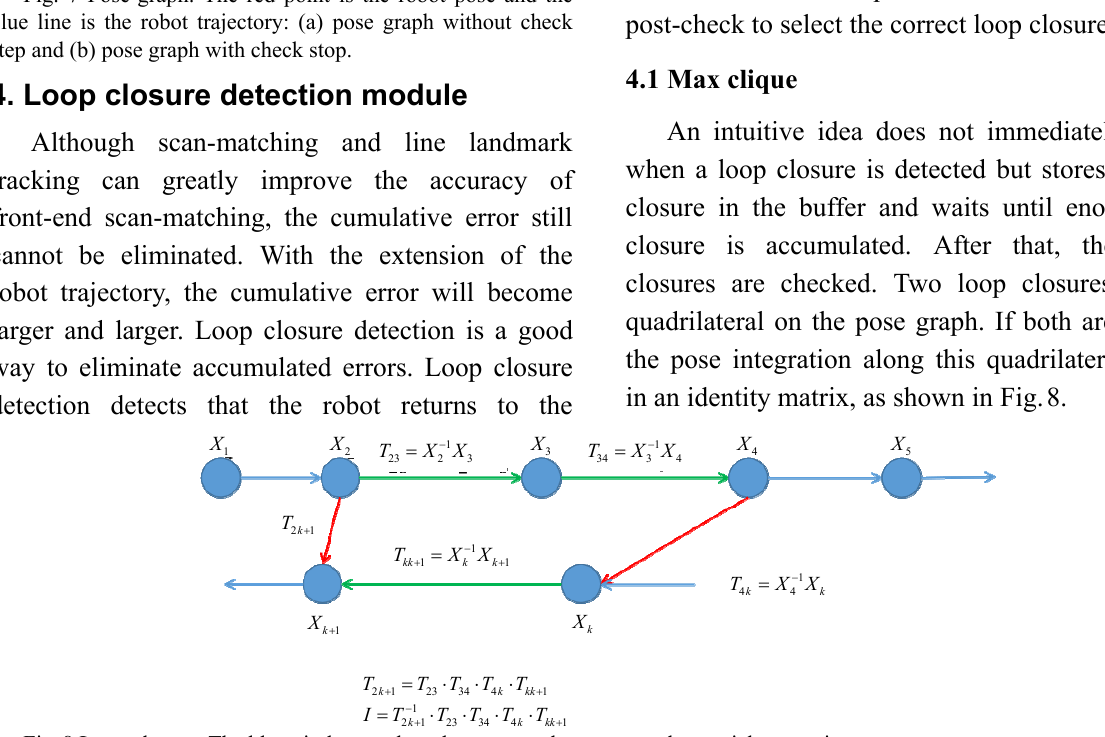
Fig. 8 Loop closure. The blue circles are the robot pose and arrows are the spatial